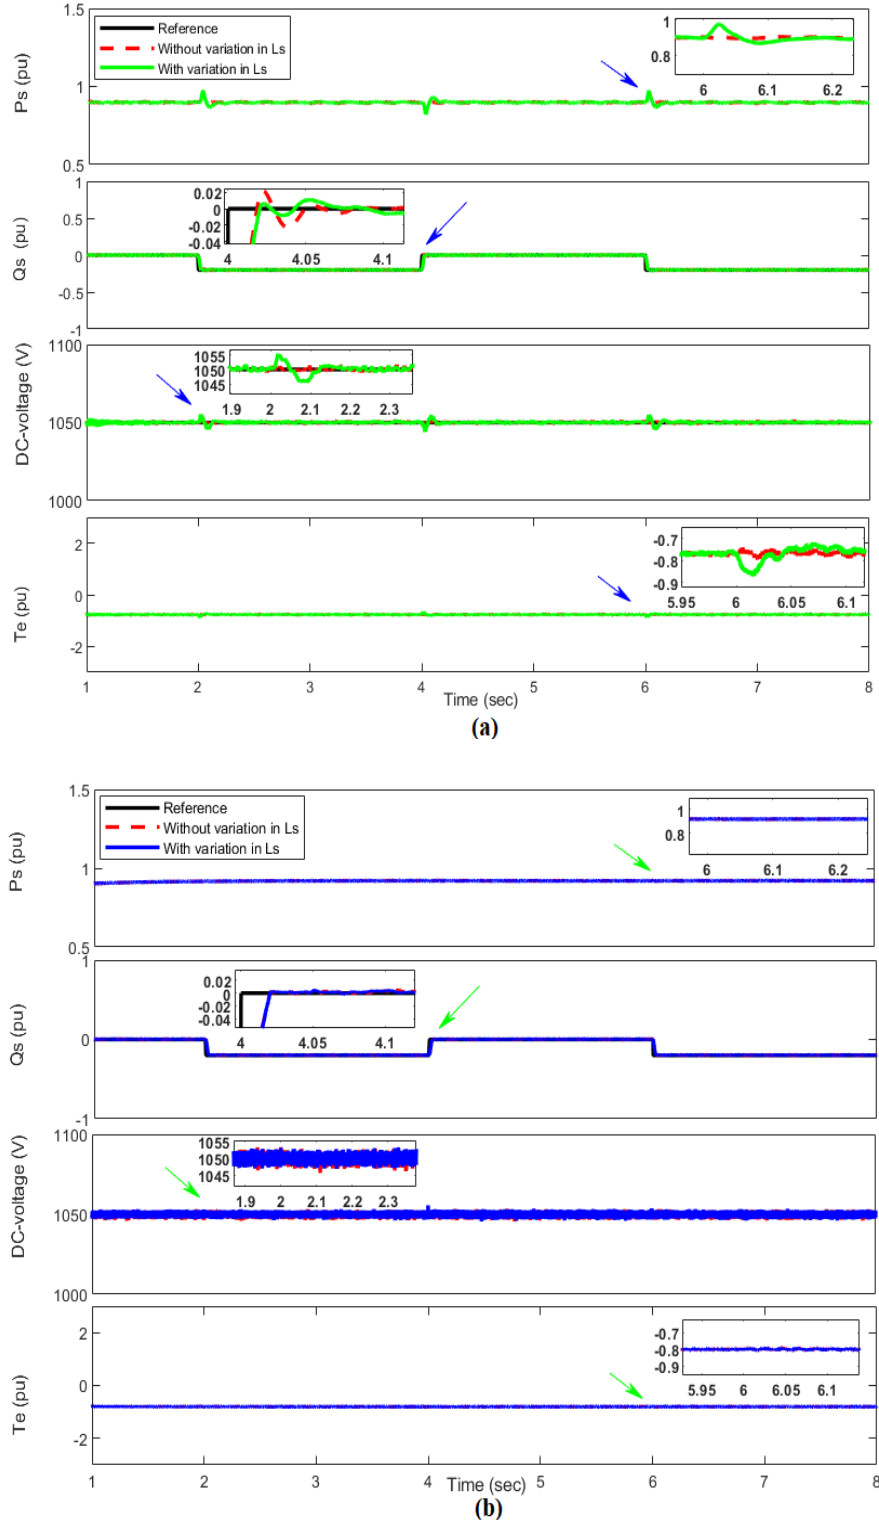
Figure 12. Simulation results of di ff erent control dynamics under the influence of stator inductance variations: ( a ) PI controller; ( b ) STA-SOSM controller.